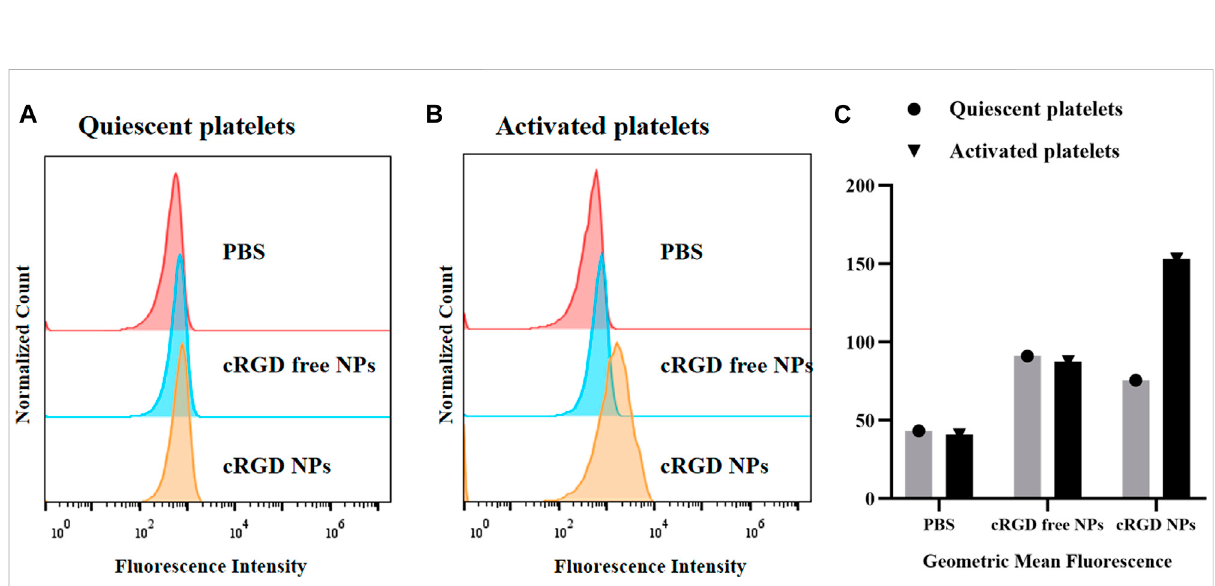
FIGURE 5 Flowcytometryanalysisofbindingaf fi nityoftheNPsto (A) freshlypreparedquiescentplateletsand (B) activatedplateletstreatedwiththrombin. (C) The geometric mean fl uorescence of PBS, ICG-uPA NPs, and cRGD-ICG-uPA NPs treated